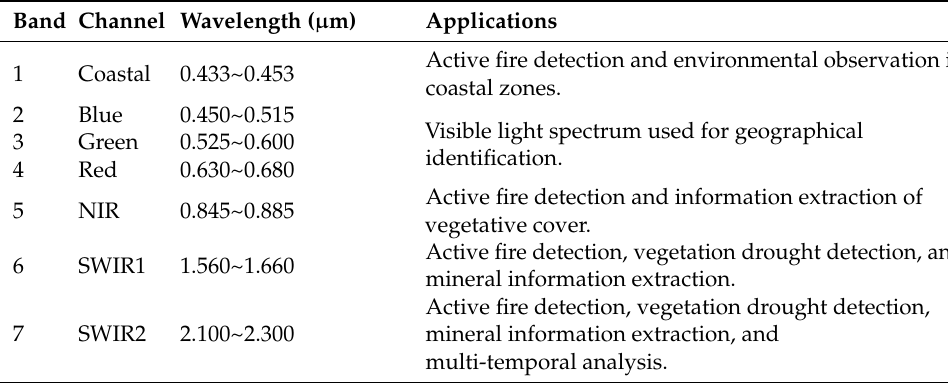
Table 1. Landsat-8 OLI multispectral